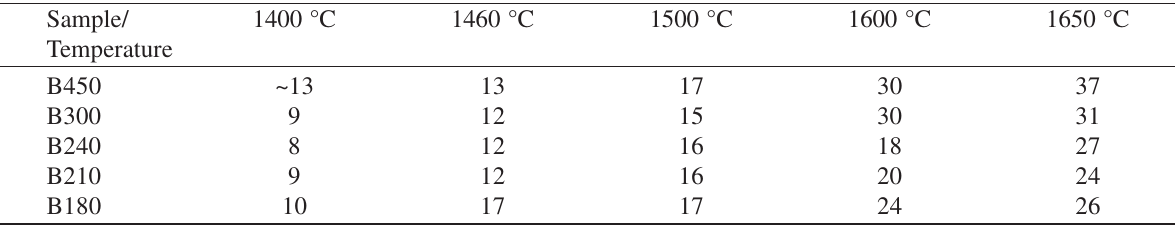
samples at different temperatures. 2